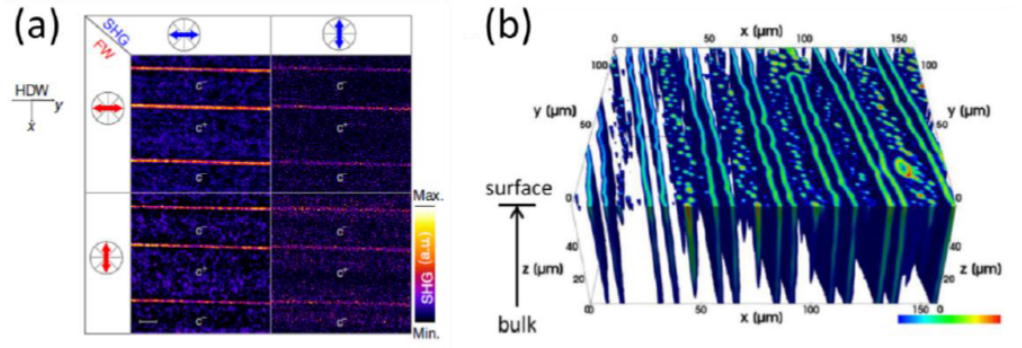
Figure 16. Three-dimensional structure of domain walls in ferroelectric crystals. ( a ) SHG image of periodic Bloch domain walls in LiTaO 3 crystals. Reprinted from [122]. ( b ) Three dimensional